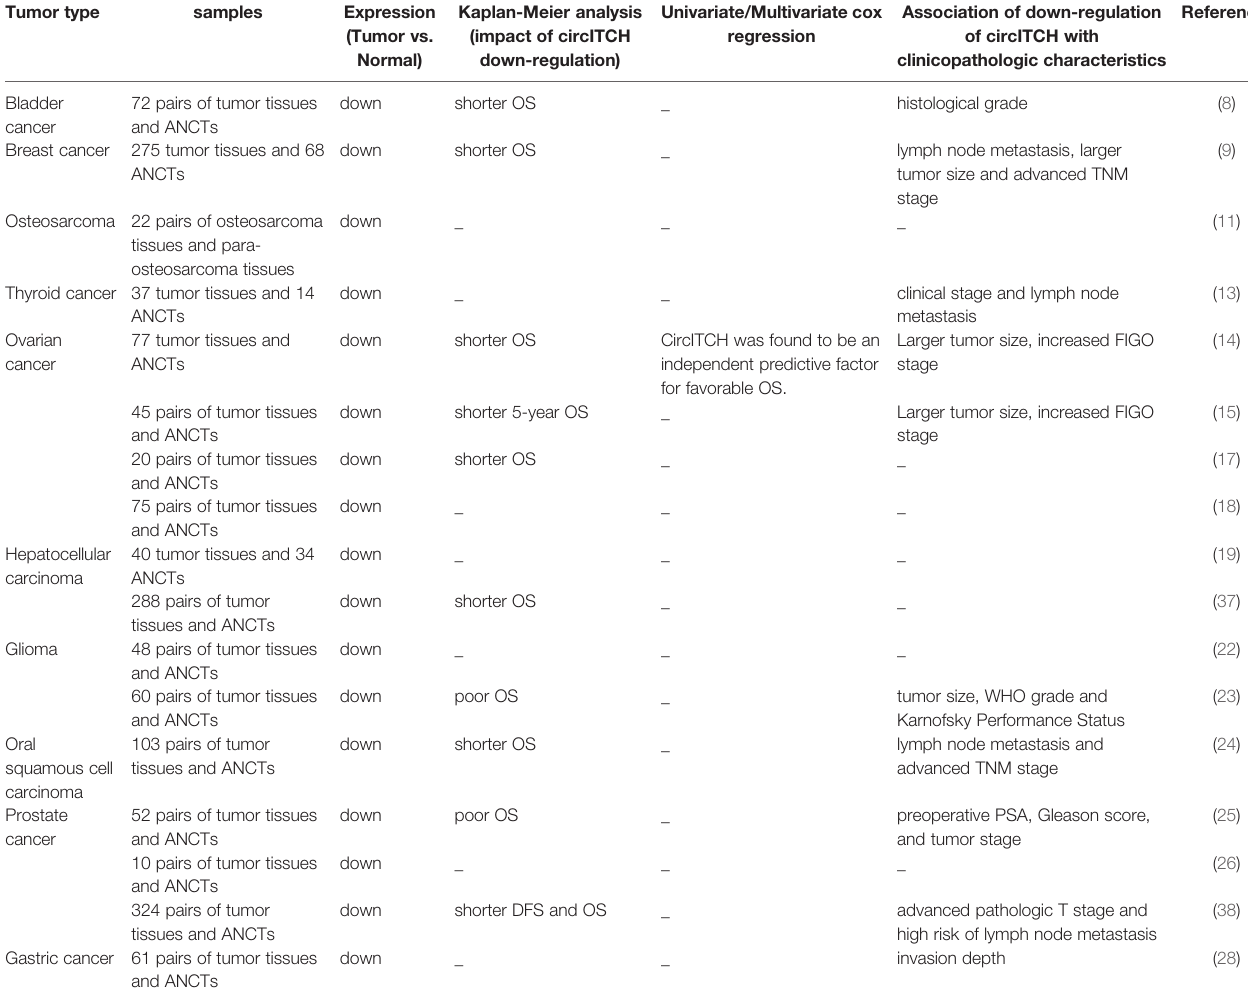
TABLE 3 | Results of studies that reported dysregulation of circITCH in clinical samples (ANCTs, adjacent non-cancerous tissues; OS, Overall survival; FIGO, International Federation of Gynecology and Obstetrics; DFS, disease-free survival; TNM, tumor ‐ node ‐ metastasis). Tumor type samples Expression (Tumor